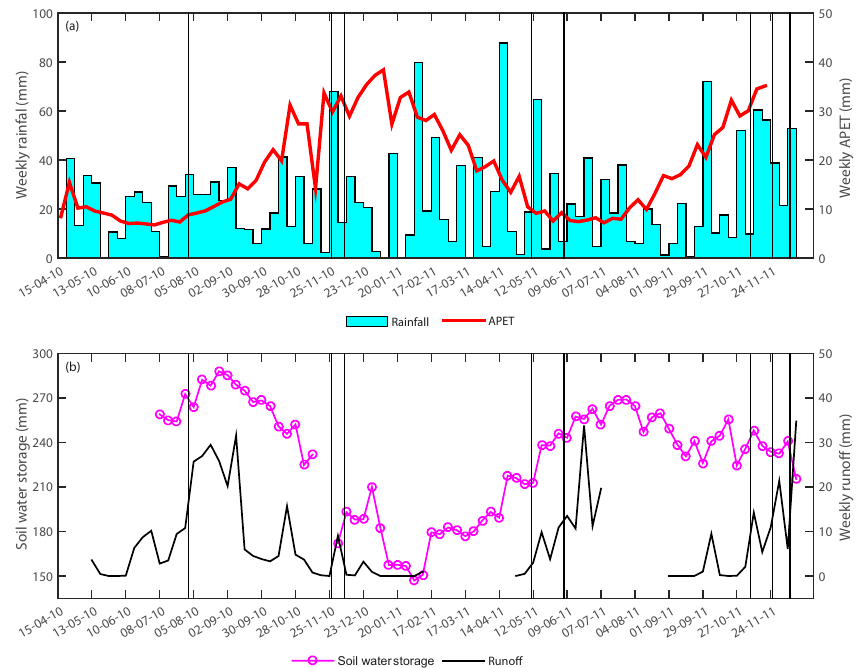
Figure 3. (a) Weekly rainfall and APET (areal potential evapotranspiration) time series, (b) soil water storage in the top 60cm of the soil profile and weekly runoff time series for the flume at the catchment outlet. The rainfall, areal potential evapotranspiration and volumetric soil moisture used to calculate soil moisture storage were all recorded at the AWS (automatic weather station) (Fig. 1). The vertical bars show the timing of events in Fig.